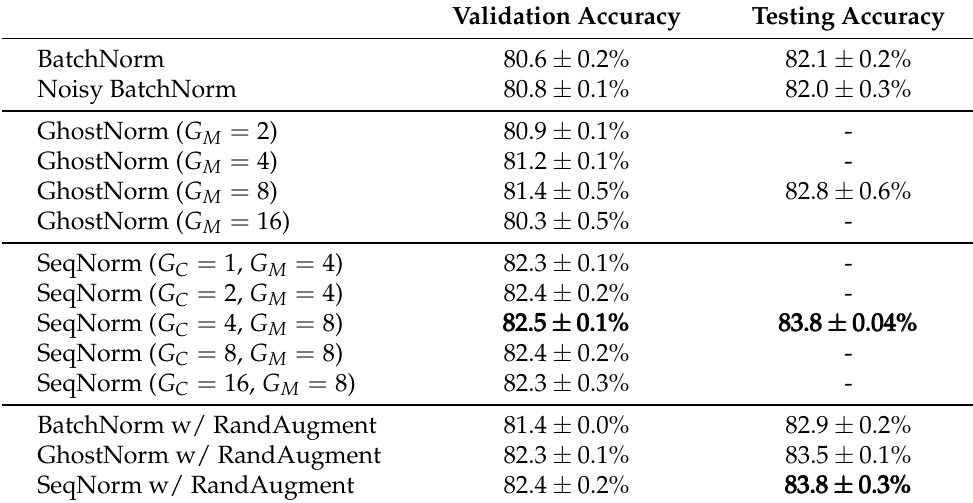
Table 1. Results on CIFAR-100. For SeqNorm, we only show the best results for each G C . Both validation and testing performance results are averaged over two different